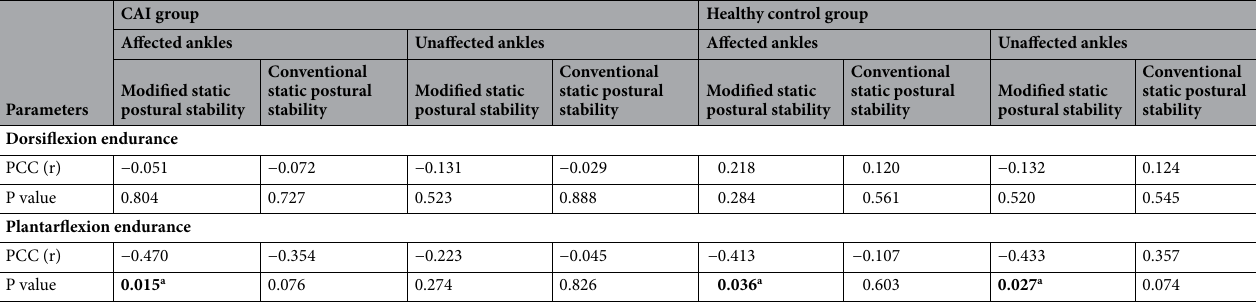
Table 3. Correlations between modified static postural stability, conventional static postural stability, and muscle endurance. Bold means statistically significant between groups. PCC Pearson’s correlation coefficient, CAI chronic ankle instability. a Statistically significant.